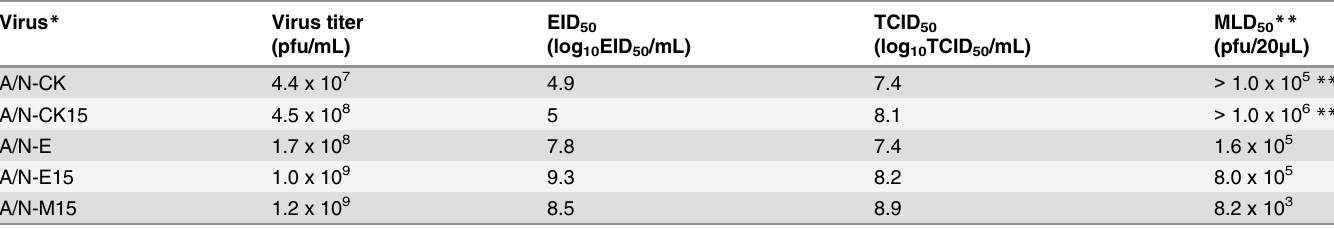
Table 2. Characterization of A/N passaged through different